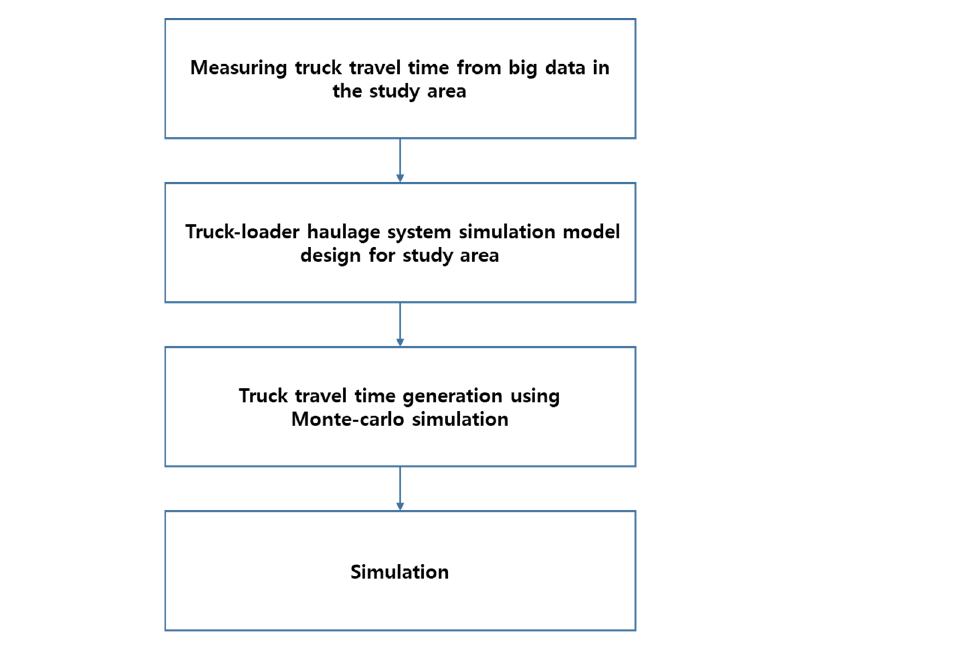
Figure 3. Study process of truck-haulage system stochastic simulation using the proposed method.